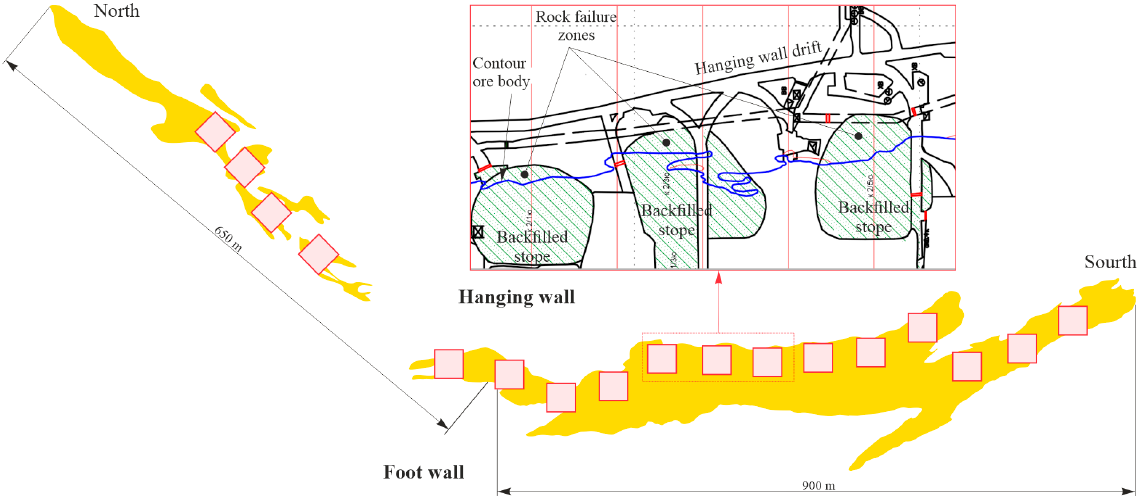
Figure 3. Schematic layout of extraction stopes at the contact with the hanging wall rocks with the fixation of their destruction zones.